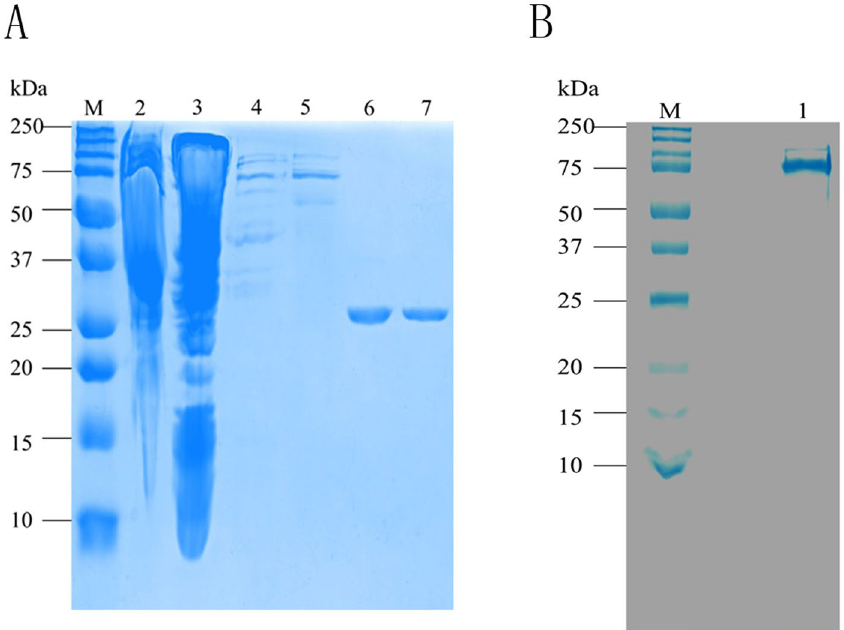
Figure 2. SDS-PAGE analysis of recombinant CgLDC and CgCAO purified by Ni- affinity chromatography. ( A ) SDS-PAGE analysis of recombinant CgLDC. Molecular mass marker (M), supernatant (lane 2), precipitant (lane 3), cell lysate of Escherichia coli BL21(DE3)-pET28a-CgLDC (lanes 4 and 5), and purified CgLDC (lanes 6 and 7). ( B ) SDS-PAGE analysis of recombinant CgCAO. Molecular mass marker (M), purified CgCAO (lane